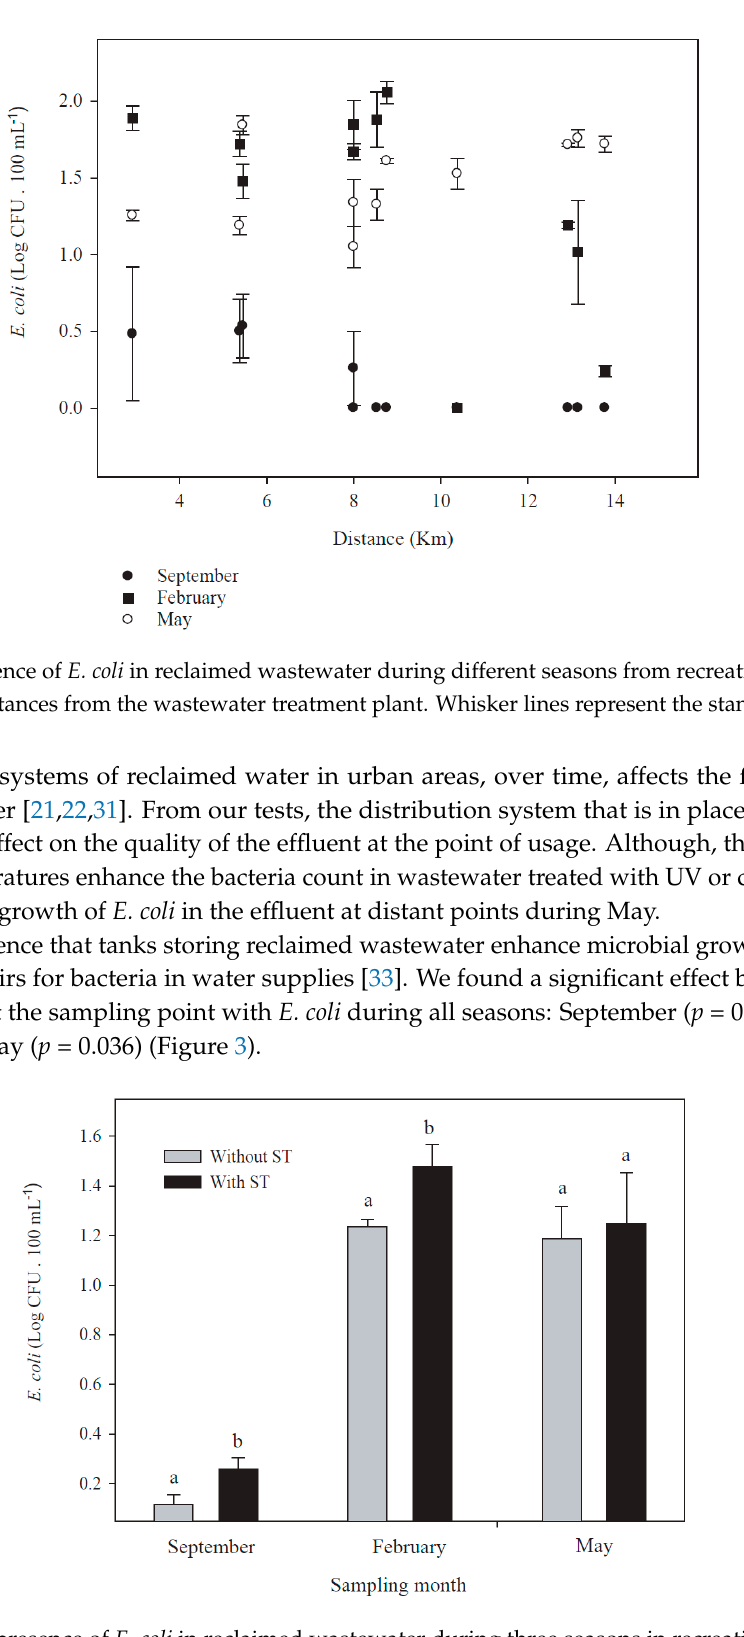
Figure 3. The presence of E. coli in reclaimed wastewater during three seasons in recreational parks with or without storage tanks (ST). Different letters indicate significant differences between conditions, using Student’s t -test for independent samples at p < 0.05. Whisker lines represent the standard